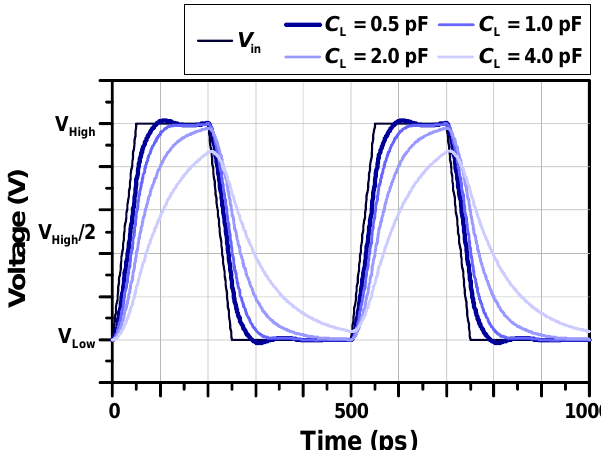
Figure 15: RC-SPICE Transient responses versus load C L for case 2.